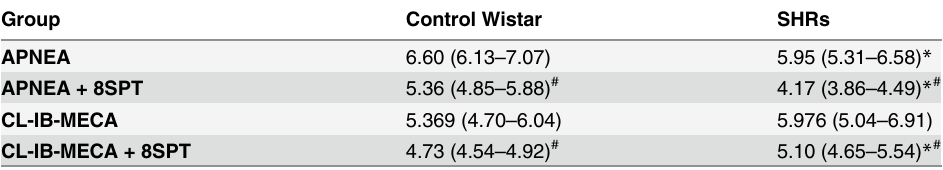
Table 3. pEC 50 values for APNEA and CL-IB-MECA concentration response curves in the absence and presence of 8SPT (10 -5 M) for control (normotensive Wistar rats) and spontaneously hypertensive rats (SHRs).